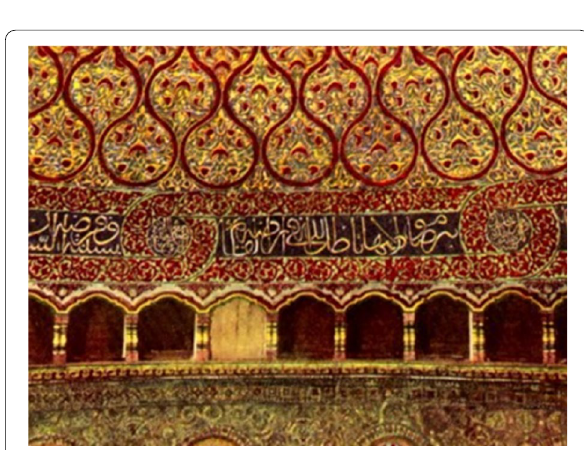
Fig. 4 Interior view of the Dome of rock